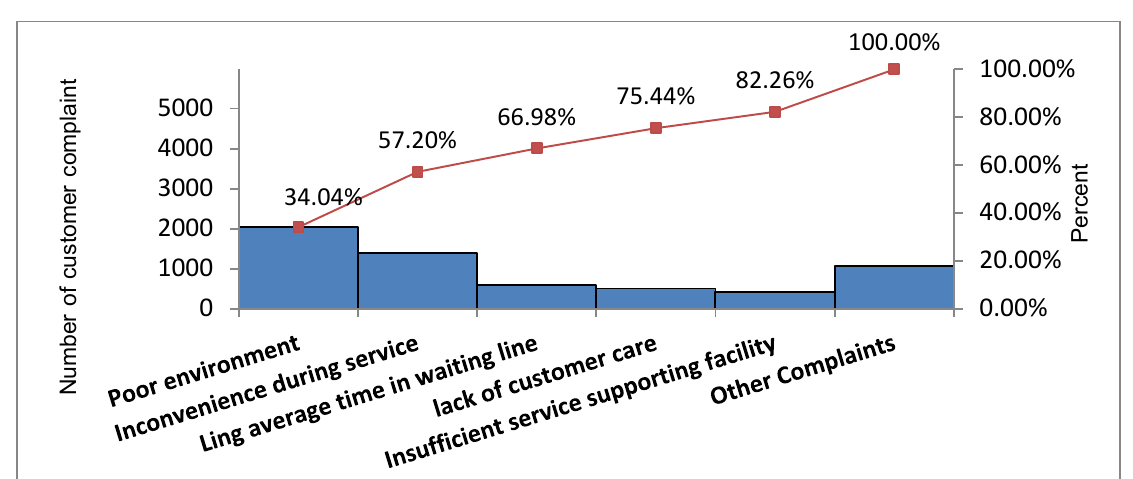
Fig. 2. Research methodology.